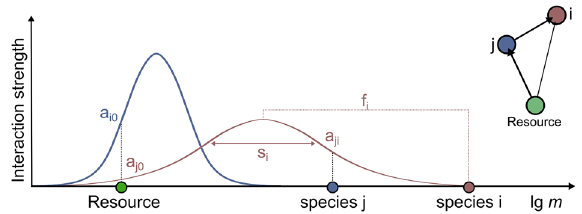
Figure 1. Illustration of the food web construction. Species are determined by their body mass and Gaussian feeding kernels. Any species inside this feeding kernel is possible prey for a species. The inset shows the resulting food